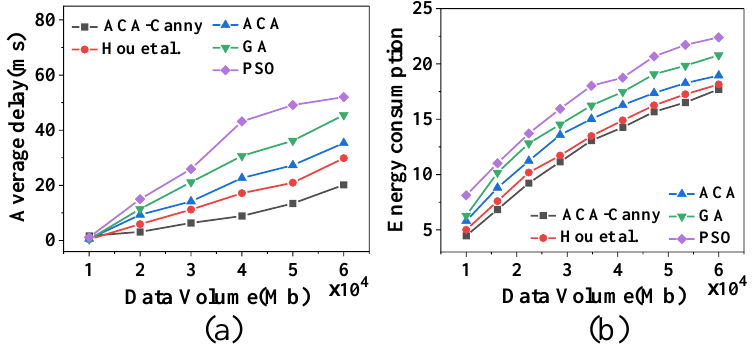
Figure 10. Energy consumption and delay changes in algorithms under various data amounts ( a ) delay; ( b ) energy consumption.